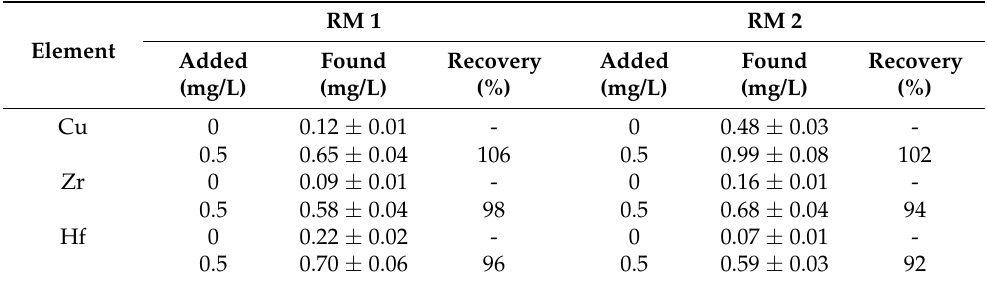
Table 7. Analytical results and recovery data for analytes in waste SmCo reference materials. The determination of analytes was carried out via ICP-OES with preconcentration. Sorption conditions: 0.1 mol/L HCl, C EDTA/NH3 = 50/2500 mg/L, m PTE = 0.1 g, V liquid phase = 10 mL, time = 30 min,